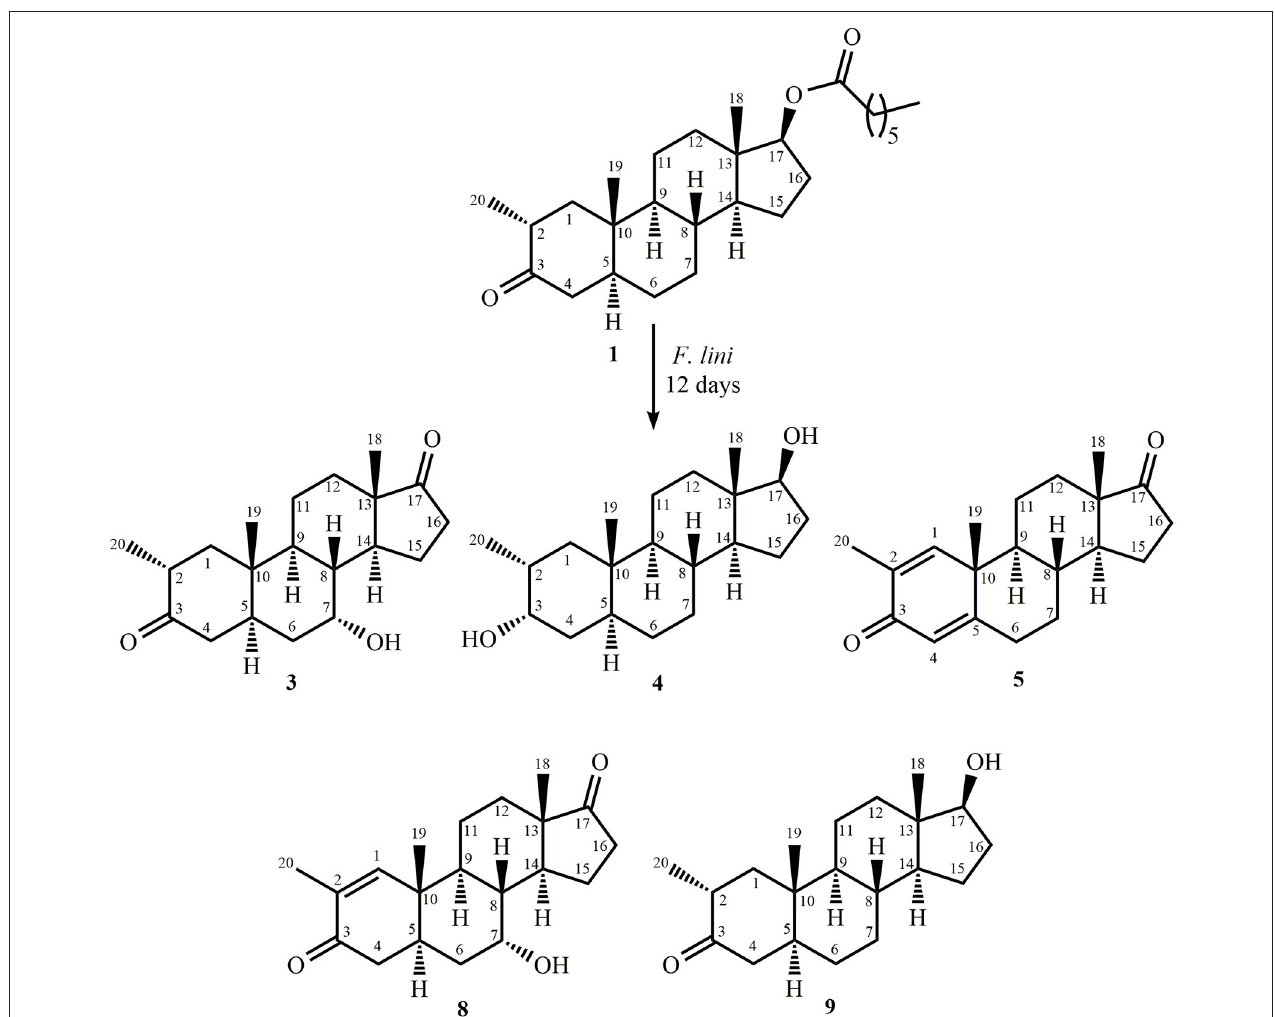
FIGURE 2 | Biotransformation of drostanolone enanthate ( 1 ) with Fusarium lini.